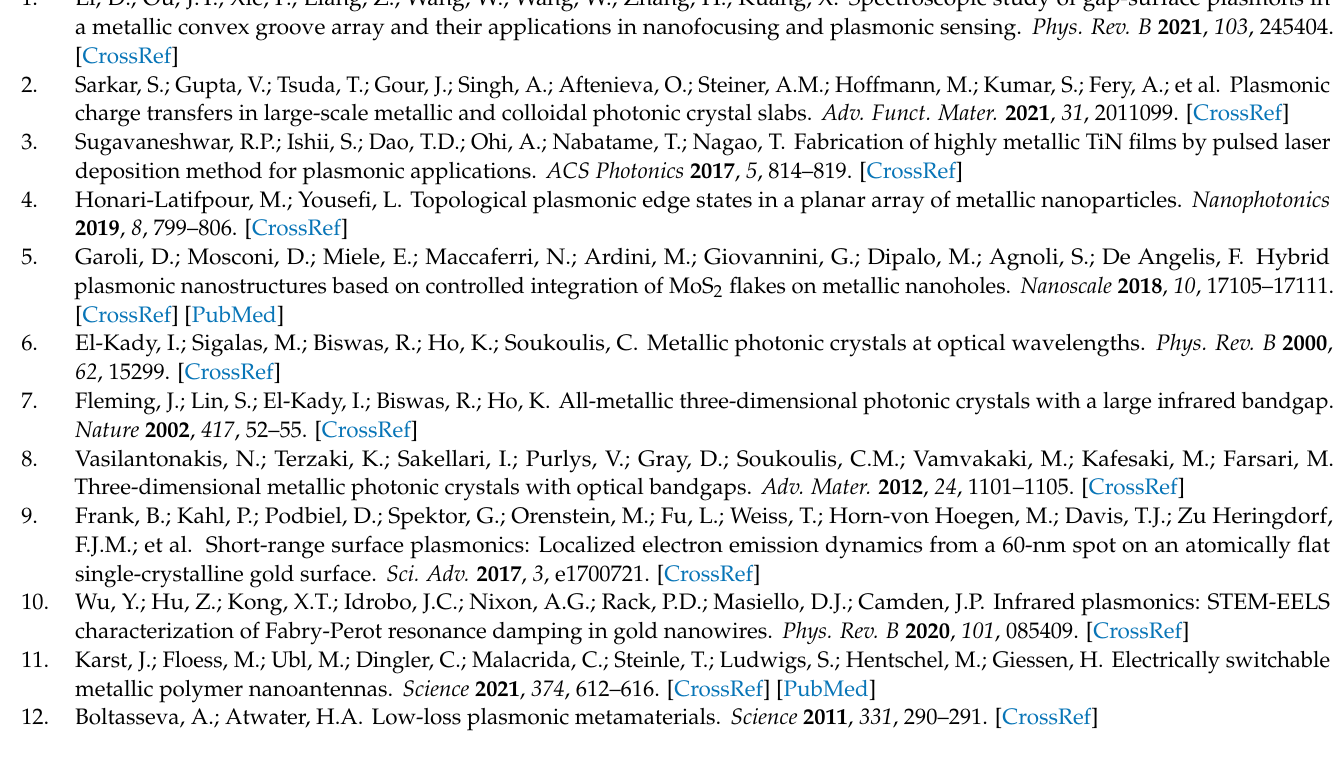
Figure S3: Transmission for 2D MPHCs consists of 15 × 15 silver rods in air under TM polarized Gaussian wave for the A, B, and C types of (a) straight and (b) L-shaped waveguides. For calculating the transmission spectra, no position and radius disorderings are considered; Figure S4: Normalized electric field spectra of 2D MPHCs contain silver rods in air for A, B, and C